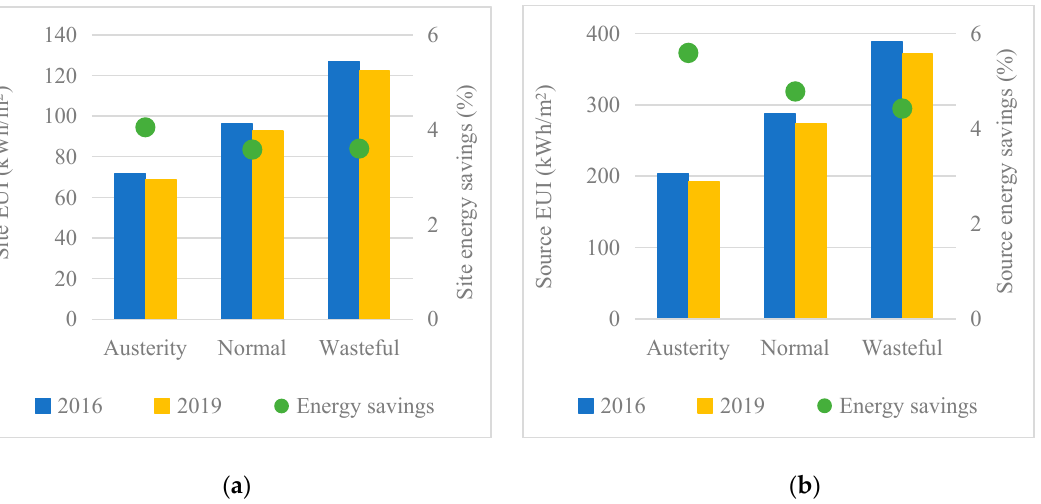
Figure 10. The national EUI and energy savings for the three occupant behavior styles: ( a ) Site EUI and energy savings; ( b ) Source EUI and energy savings.